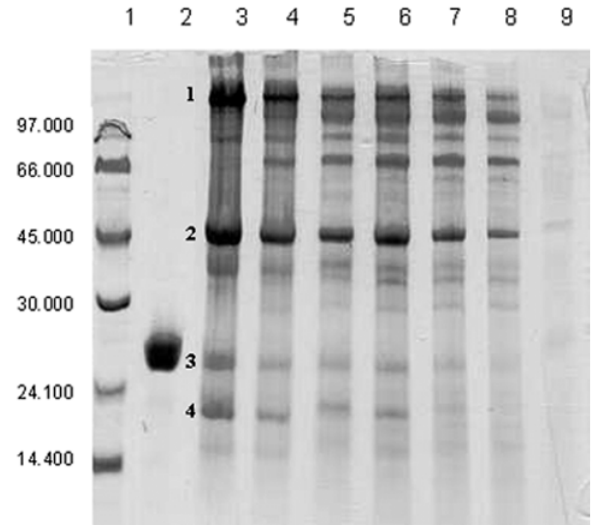
Figure 3. Proteolysis of muscle proteins induced by neuwiedase. Line 1: MW markers (GE Healthcare, USA): phosphorylase b (97,000), albumin (66,000), ovalbumin (45,000), carbonic anhydrase (30,000), trypsin inhibitor (24,100), α-lactoalbumin (14,400). Line 2: neuwiedase (5 µg). Line 3: control myofibrils incubated with PBS for 24 hours. Lines 4-9: myofibrils incubated with neuwiedase for 5, 30 and 60 minutes, and 3, 6, and 24 hours,